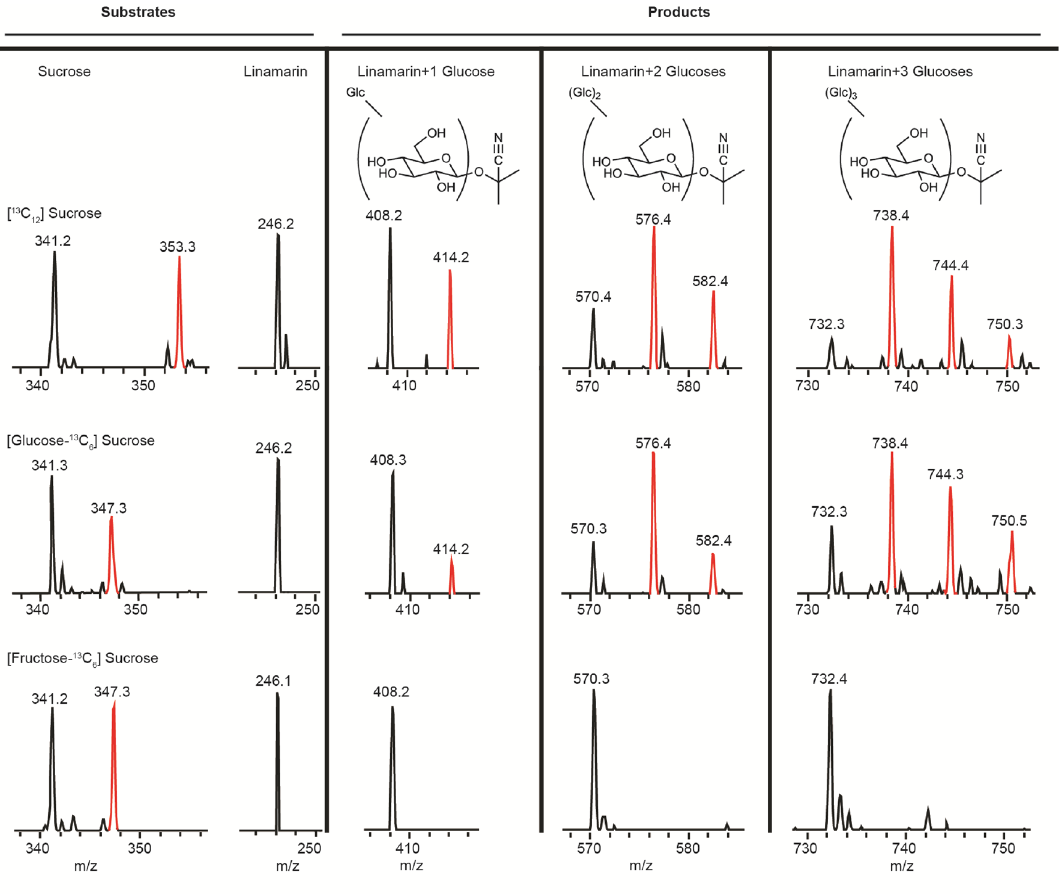
Figure 5. Evidence for enzymatic mechanism of linamarin glucosylation by B. tabaci . Glucosylation of cyanogenic glycosides in B. tabaci is catalyzed by a transglucosidase activity based on feeding of [ 13 C] sucrose isotopologues and linamarin to insects in artificial diet. Shown are MS regions from LC–MS analyses of substrates and products of feeding experiments on three different diets. Feeding fully 13 C-labeled sucrose and sucrose 13 C-labeled in the glucose moiety gave labeling in the newly added glucose of glucosylated linamarin metabolites. However, feeding sucrose 13 C-labeled in the fructose moiety gave no label in the products, demonstrating incorporation of only the glucose of sucrose into the products. Feeding of free 13 C-labeled glucose and fructose with linamarin also resulted in no incorporation into glucosylated derivatives of linamarin (Supplementary Figure S4), showing that the glucose must originate from sucrose as expected in transglucosidase